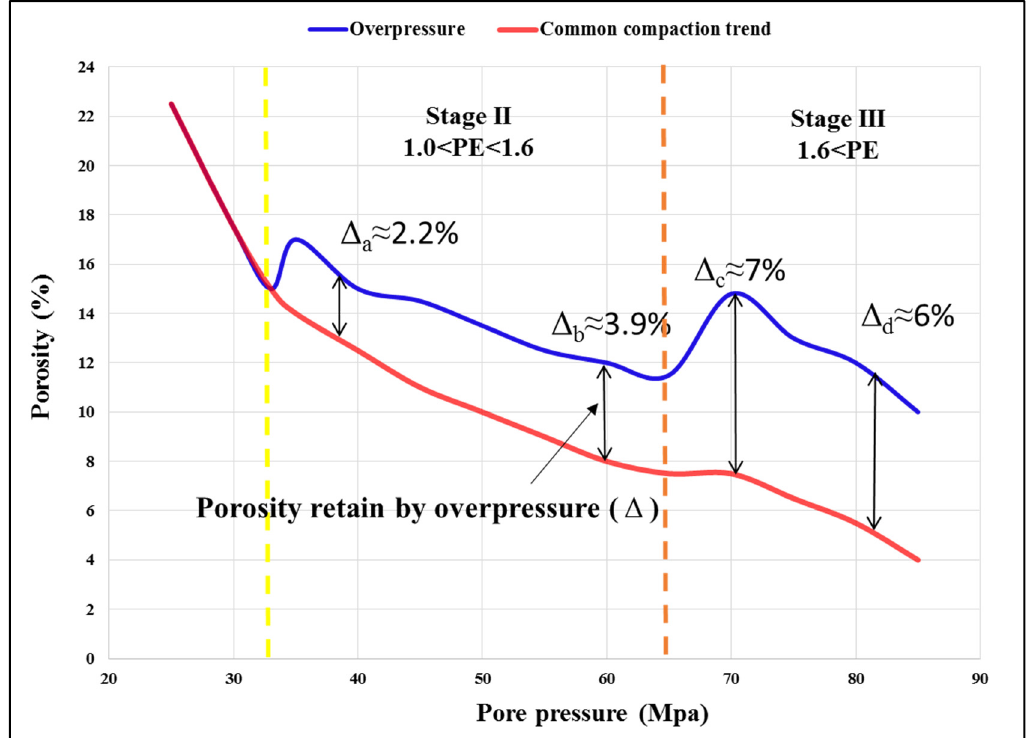
Figure 19. Quantitative analysis of the effect of overpressure on